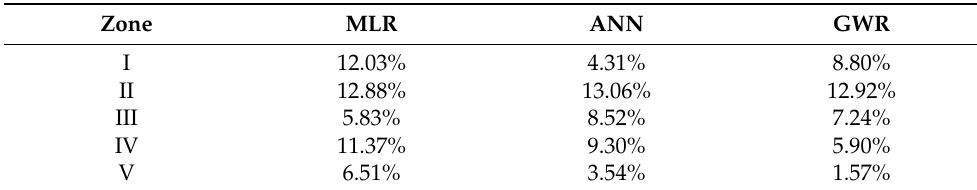
Table 4. The coefficient of variation of the correction methods.